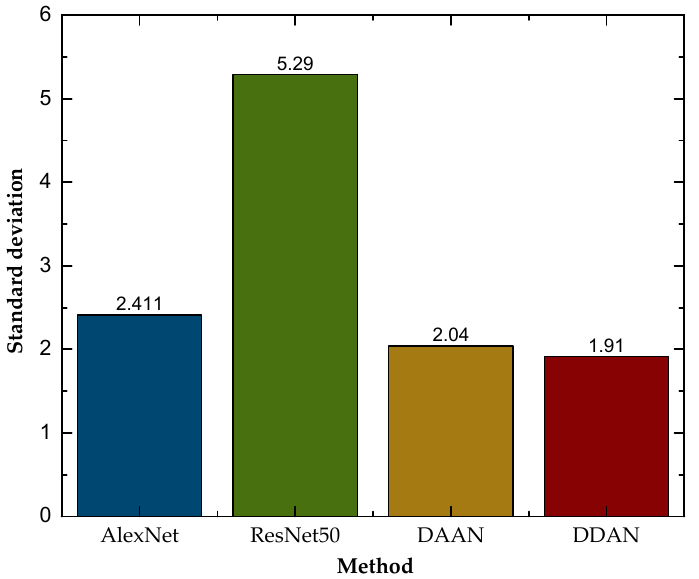
Figure 10. Standard deviation of different